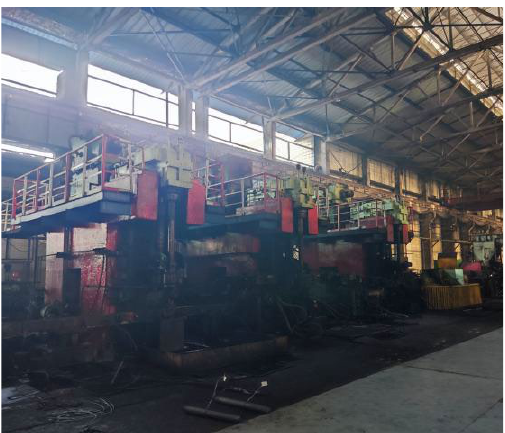
Figure 2. Photograph of the rough rolling mill.